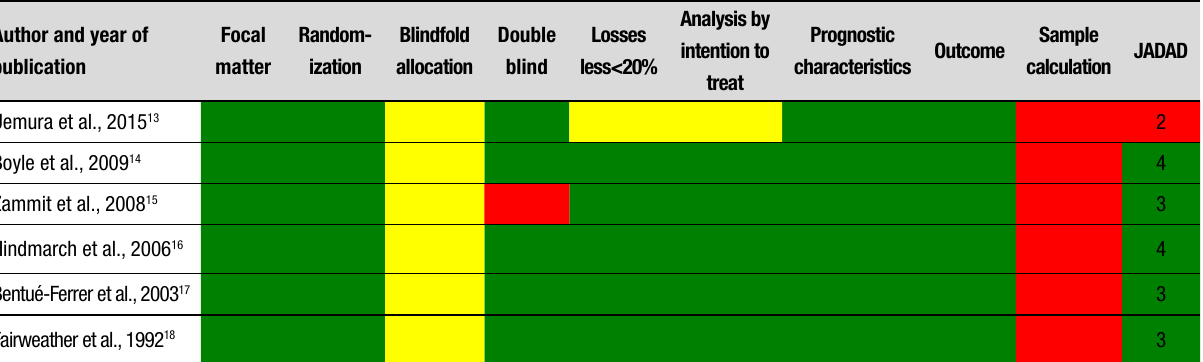
Table 2. Bias of included